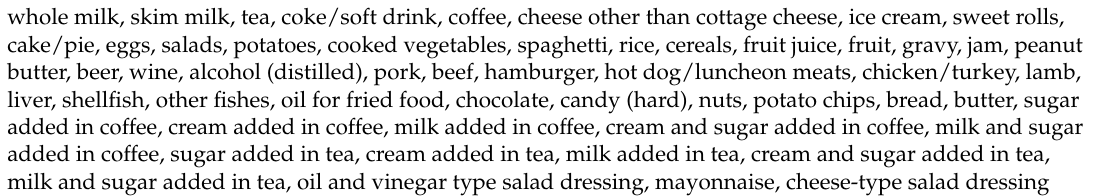
Table 1. Food items in the NHLBI Twin Study food composition Table 3.3.0.1 used for